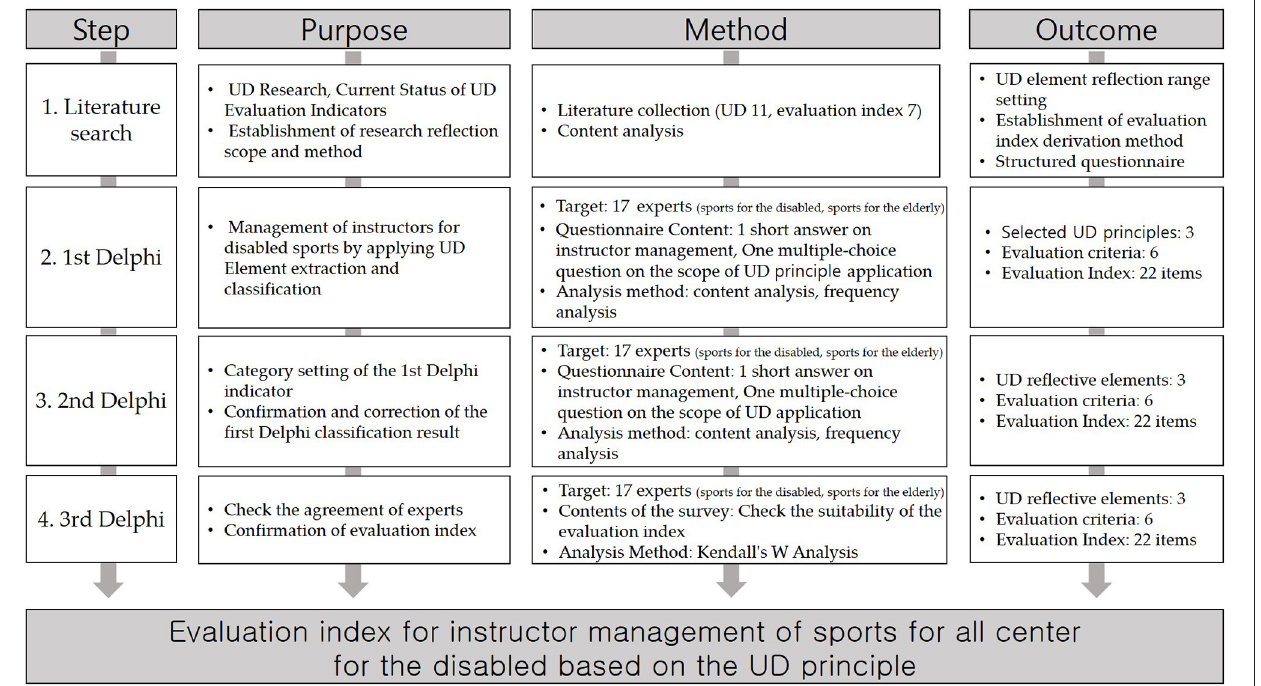
FIGURE 1 | Research